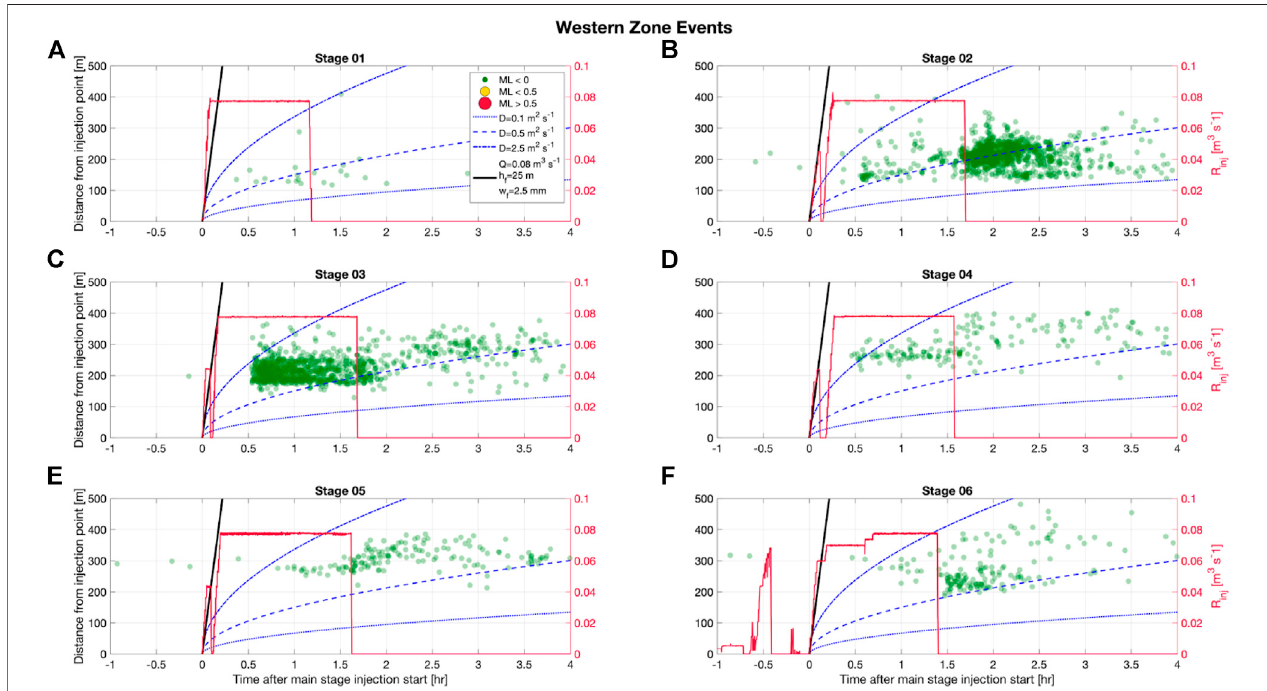
FIGURE 3 | Spatiotemporal evolution of microseismicity (dots, colored and sized by magnitude) within the western clusters for each injection stage. We also show the injection rate ( R inj , red line), and the expected time-distance behavior produced by diffusion models with D (cid:2) 0.1, 1 and 2.5 m 2 /s (blue dashed lines), and a simple hydraulic fracture model (black line) assuming h f (cid:2) 25 m, w f (cid:2) 2.5 mm and no fl uid loss.